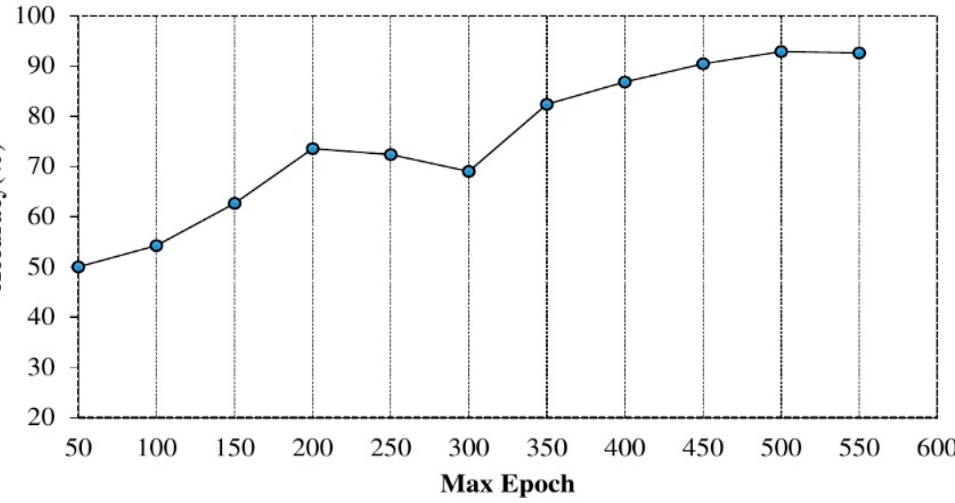
Figure 6. Max epoch Versus Accuracy.